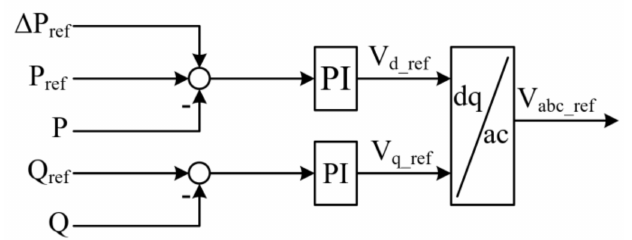
Figure 3. P and Q